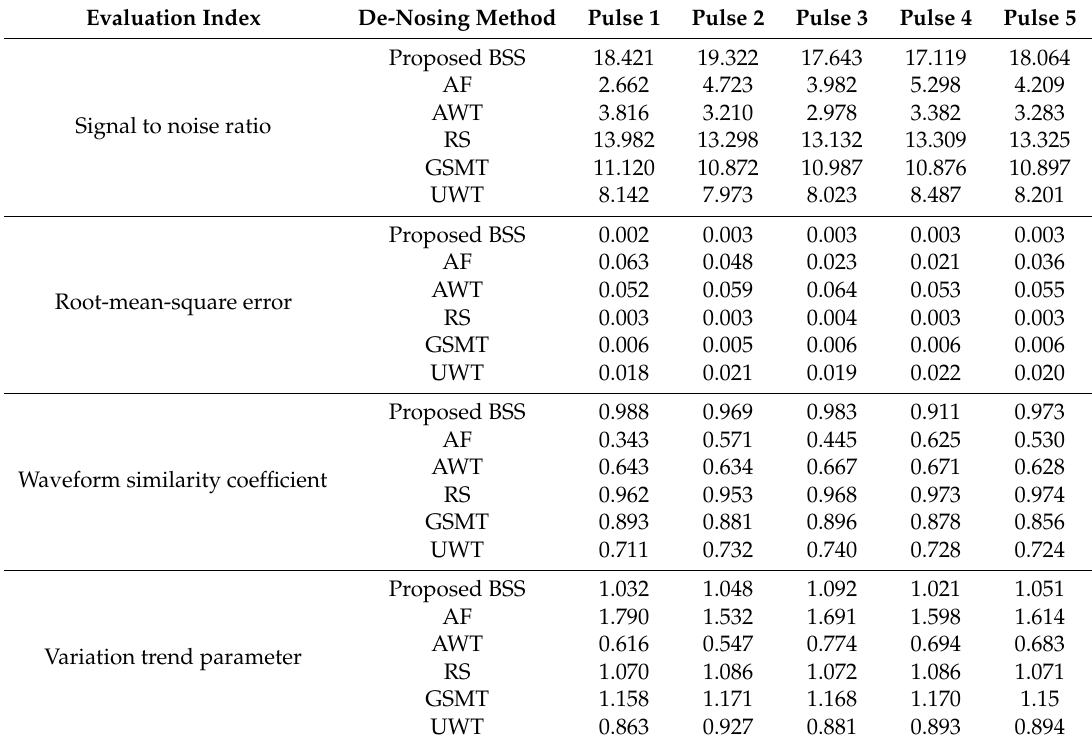
Table 3. De-noising performance evaluation